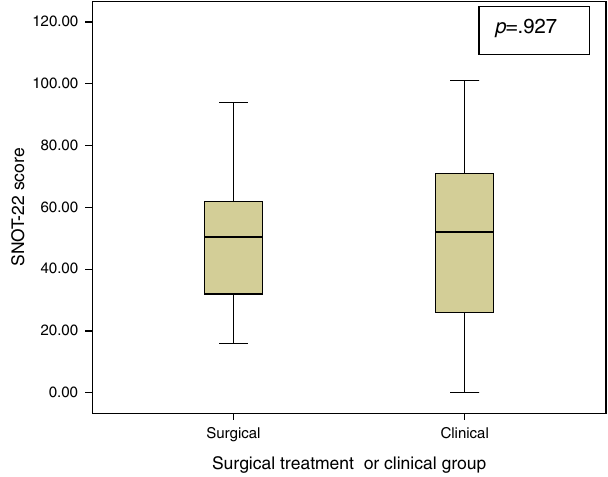
Shows the comparison of the SNOT-22 score averages of the